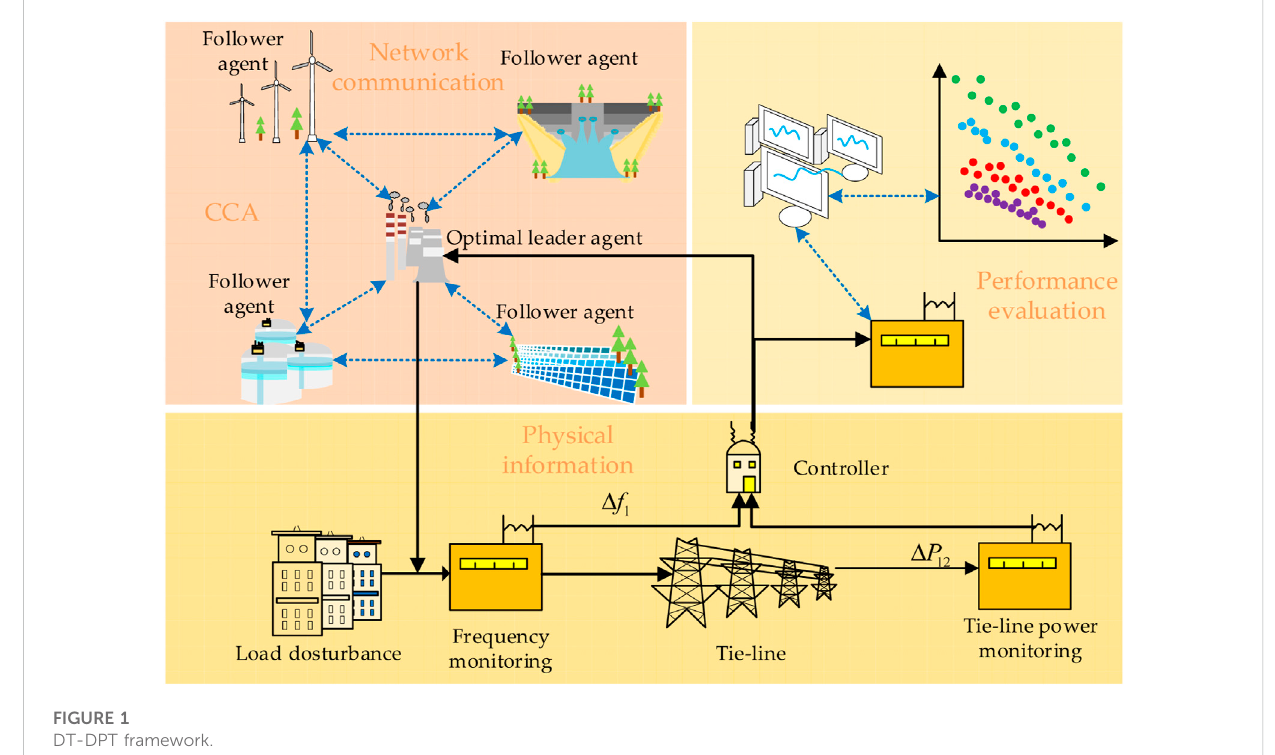
FIGURE 1 DT-DPT